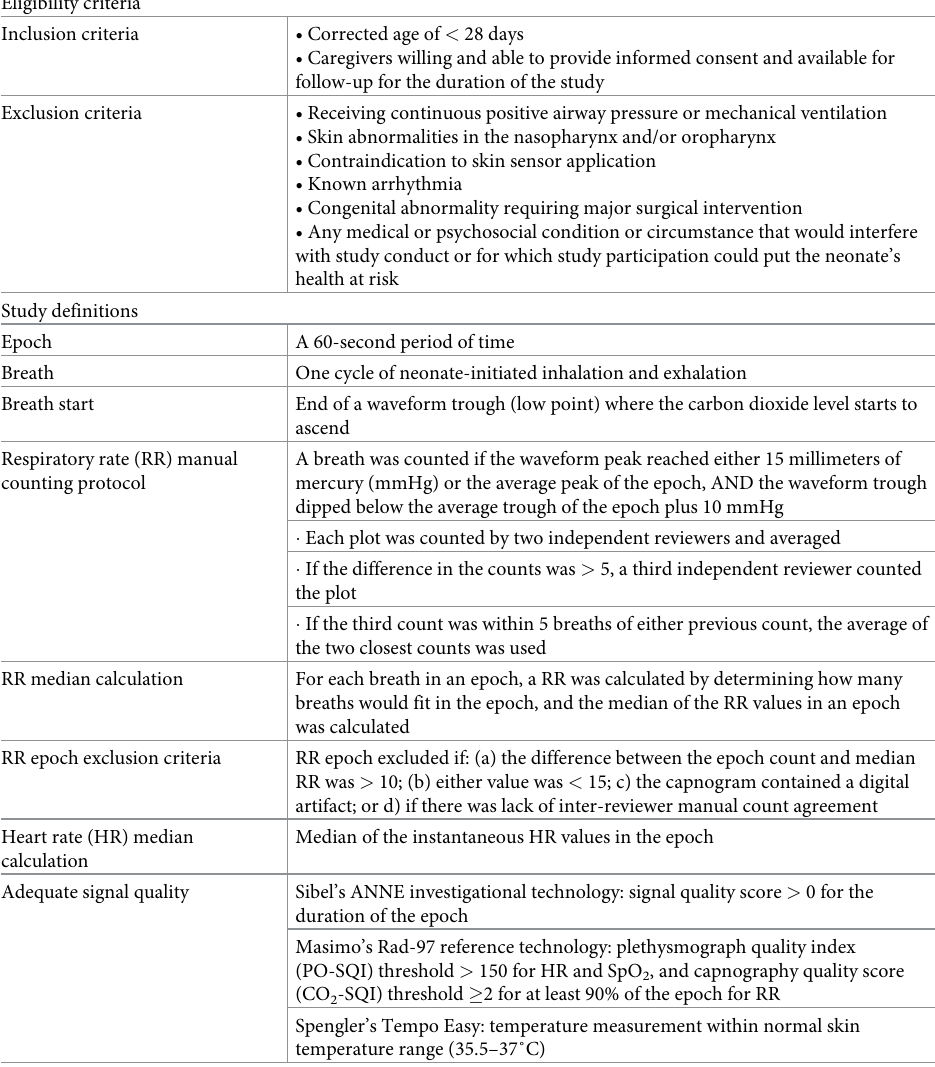
Table 1. Eligibility criteria and study